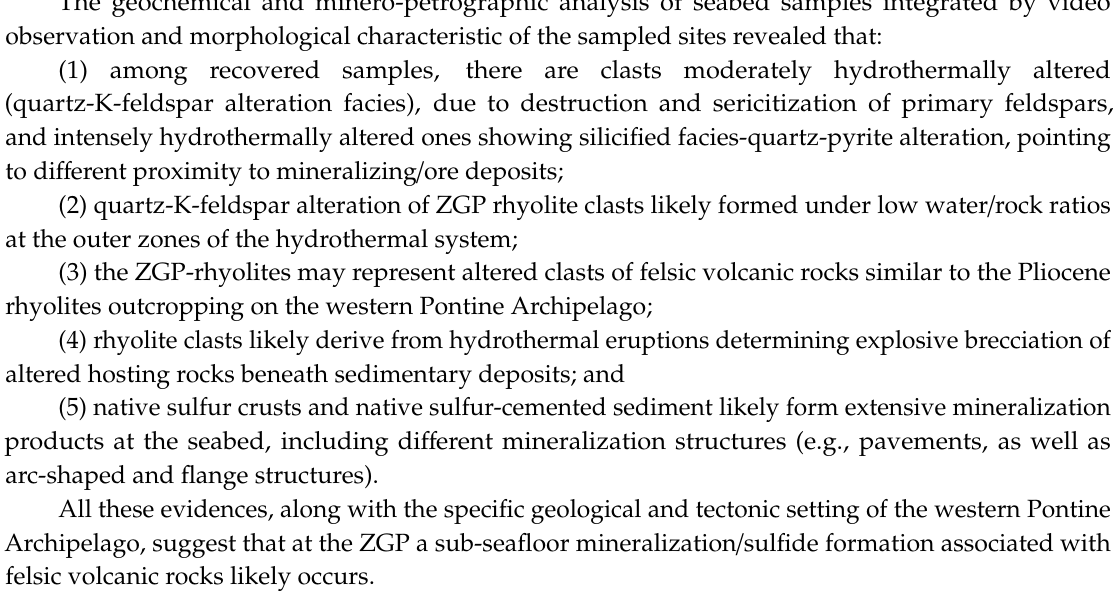
Figure S1: EDS spectra of APS minerals. Table S1: Mineral phases detected by the XRD analysis listed in order of decreasing abundance. Table S2: Chemical composition (major and trace elements) of ZGP